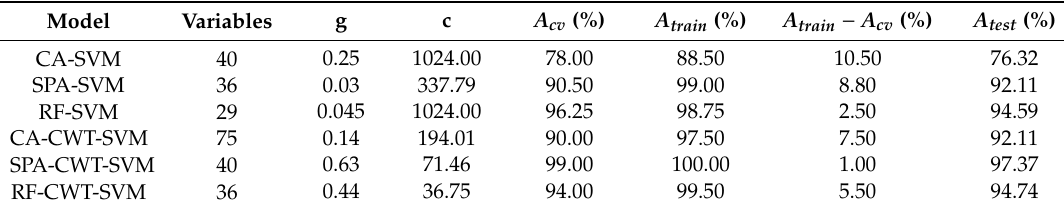
Table 5. Statistics of potato growth stage classification